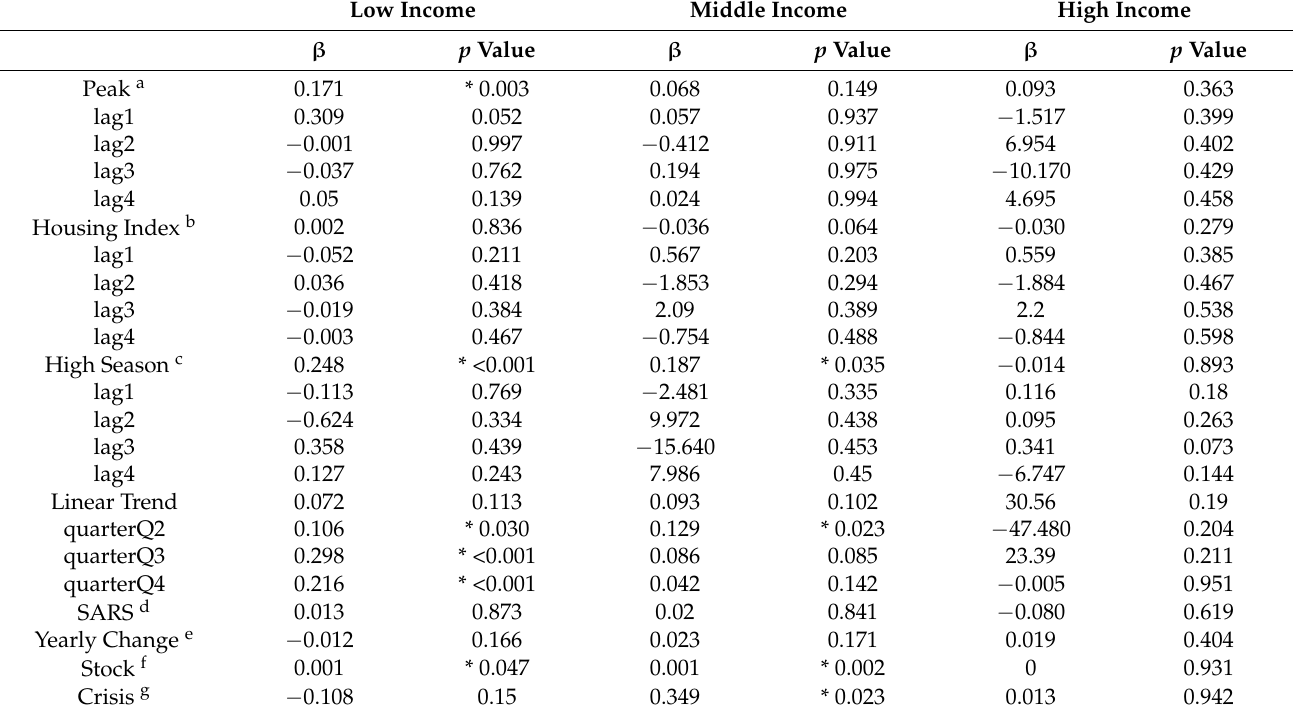
Table 3. Regression analysis of housing index and prescriptions prevalence by